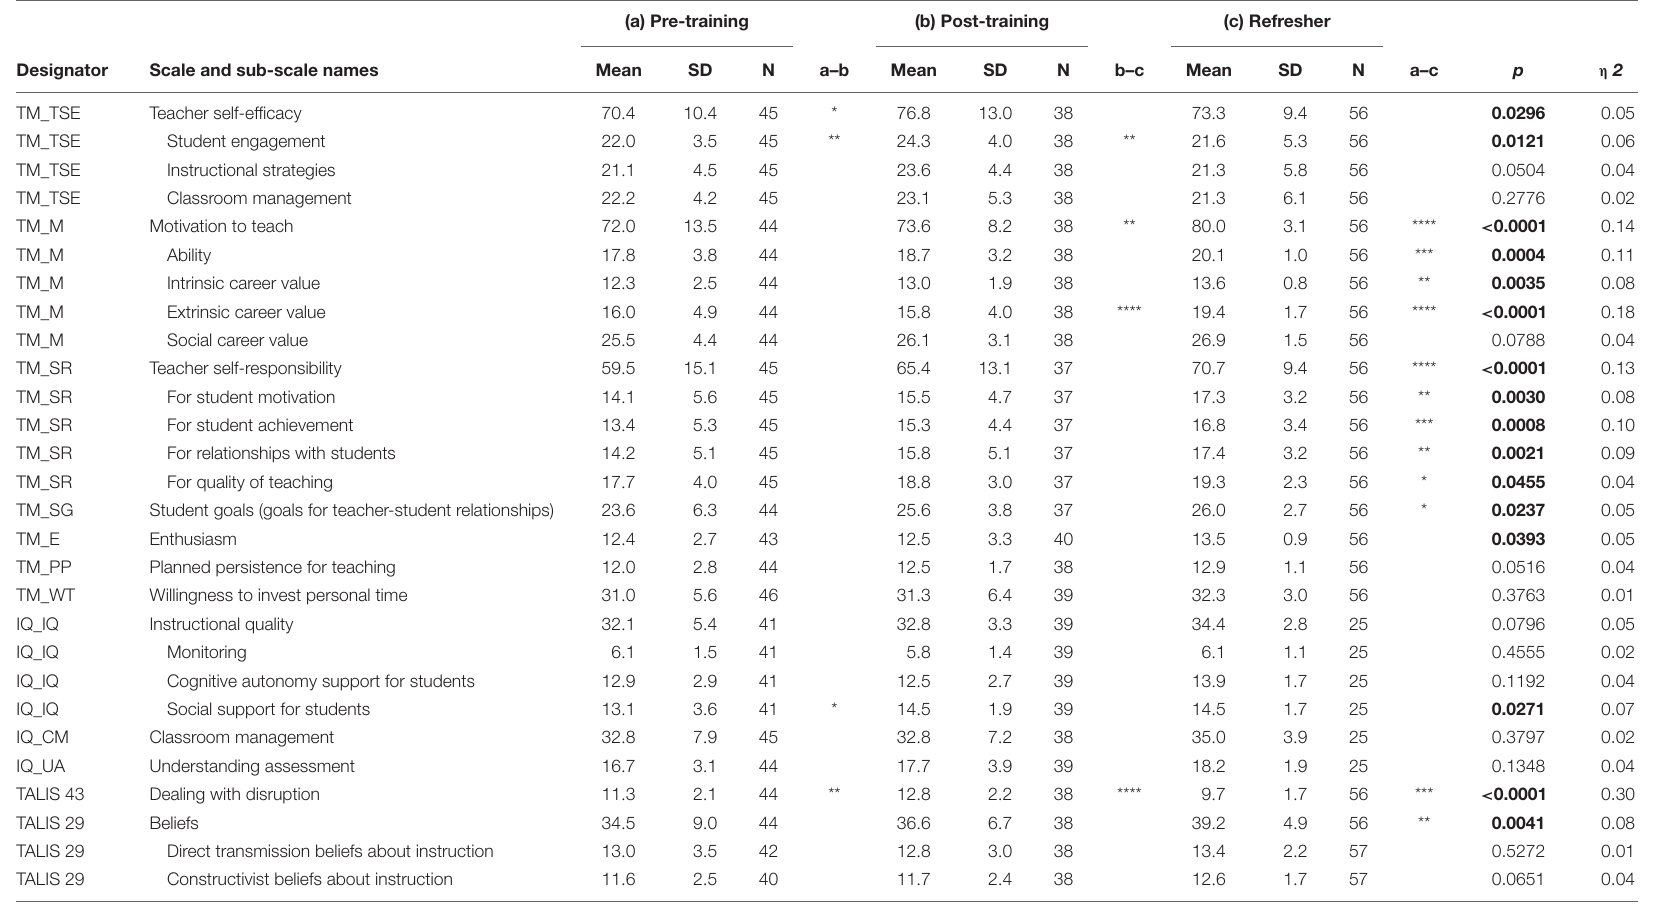
TABLE 3 | OECD Scales included in the Tier II teacher